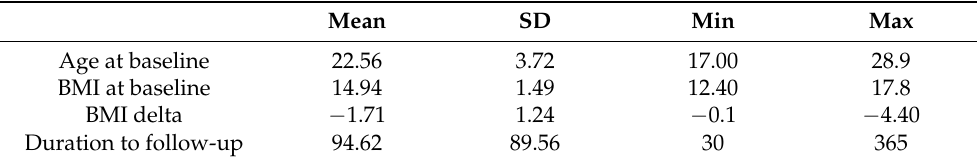
Table 1. Mean, standard deviation, and minimum and maximum of characteristics of participants